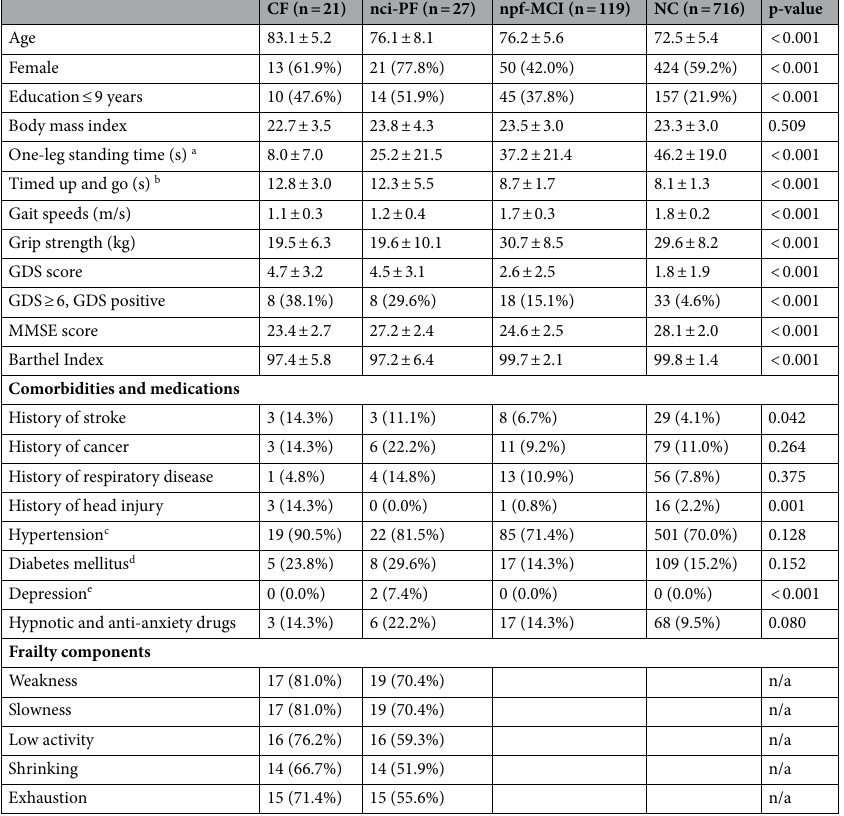
Table 2. Demographic characteristics of the participants in the four groups. Data are presented as the mean ± standard deviation, or number and proportion (percentage). Categorical variables were compared among the four groups using the chi-square test, whereas continuous demographic variables were compared using one-way analysis of variance. CF cognitive frailty, nci-PF non-cognitive-impaired physical frailty, npf-MCI non-physically-frail mild cognitive impairment, NC normal control (non-physically-frail non- cognitive-impaired individual group), GDS Geriatric Depression Scale (short version), MMSE Mini-Mental State Examination. a The test was performed while the participants’ kept their eyes open. Left and right legs were assessed in the standing position, and the better (longer) record was used (maximum being 60 s). b The test was performed at maximum walking speed. c Hypertension was defined as blood pressure ≥ 140/90 mmHg or the use of antihypertensive agents. d Diabetes was defined as fasting blood glucose ≥ 126 mg/dL, casual blood glucose ≥ 200 mg/dL, hemoglobin A1c ≧ 6.5%, or the use of glucose-lowering agents. e Depression was diagnosed by a psychiatrist based on medical information and neuropsychiatric interviews according to the Diagnostic and Statistical Manual of Mental Disorders-fourth edition (DSM-IV).